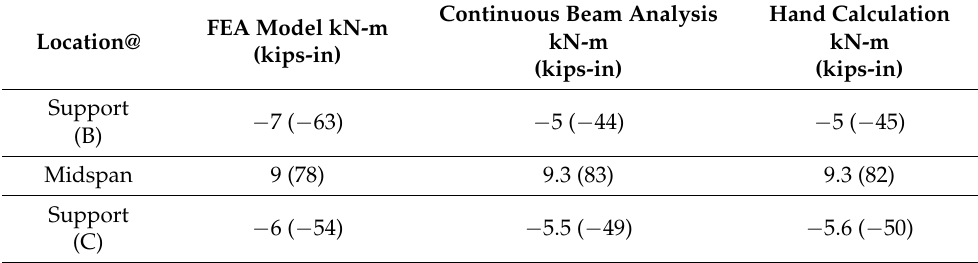
Table 2. Moment results comparison in kN-m